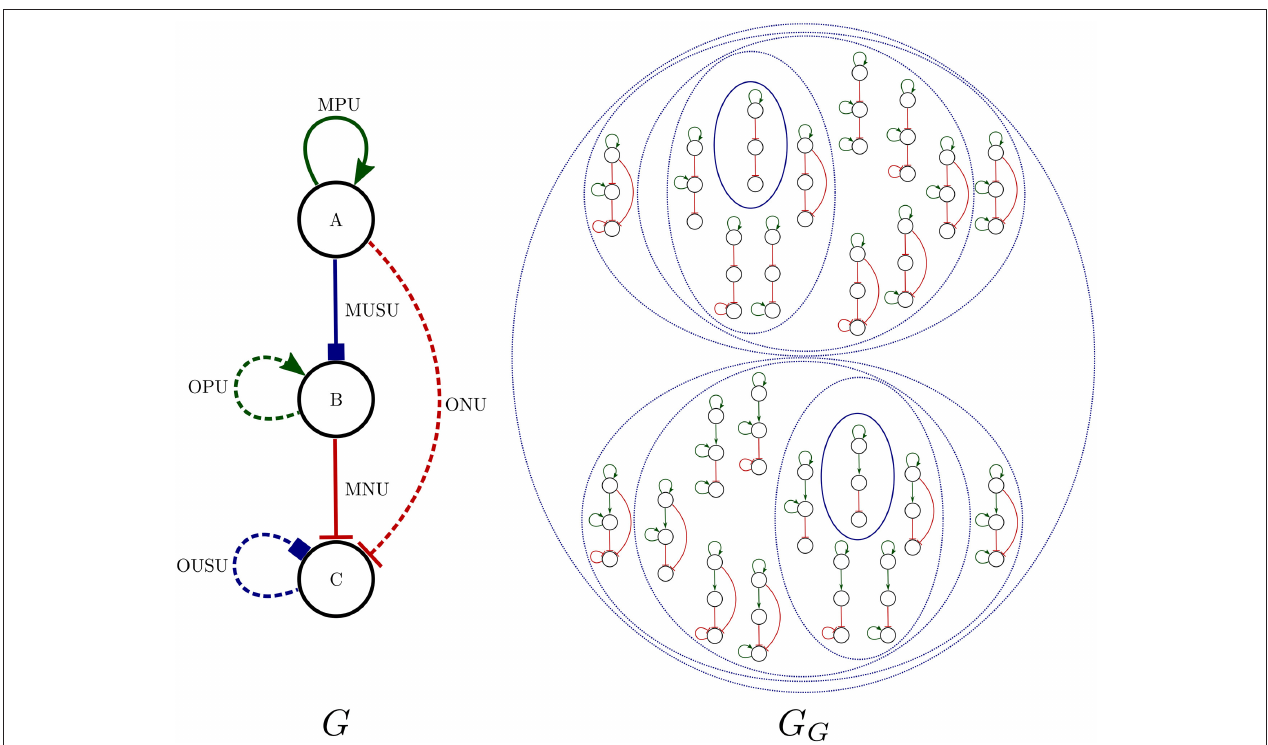
FIGURE 1 | Left: An R-graph G . Right: The set of all instantiations of G , G G (see definition 12). In the radial exploration strategy used by Griffin there are two centers contained in the continuous ovals. The nested dotted ovals illustrate regulation graphs that are at a certain radius from each center: continuous oval for radius 0, inner dotted ovals for radius 1, second inner dotted ovals for radius 2 and so on. In this example, each regulation graph of G G corresponds to an R-graph of a query member of a query splitting. The strategy used for this query splitting is shown in Algorithm 2. In general, the number of queries in the query splitting does not correspond to the number of instantiations of an R-graph, due to the fact that a member of the splitting may not have satisfying solutions, while all instantiations of G have satisfying solutions.